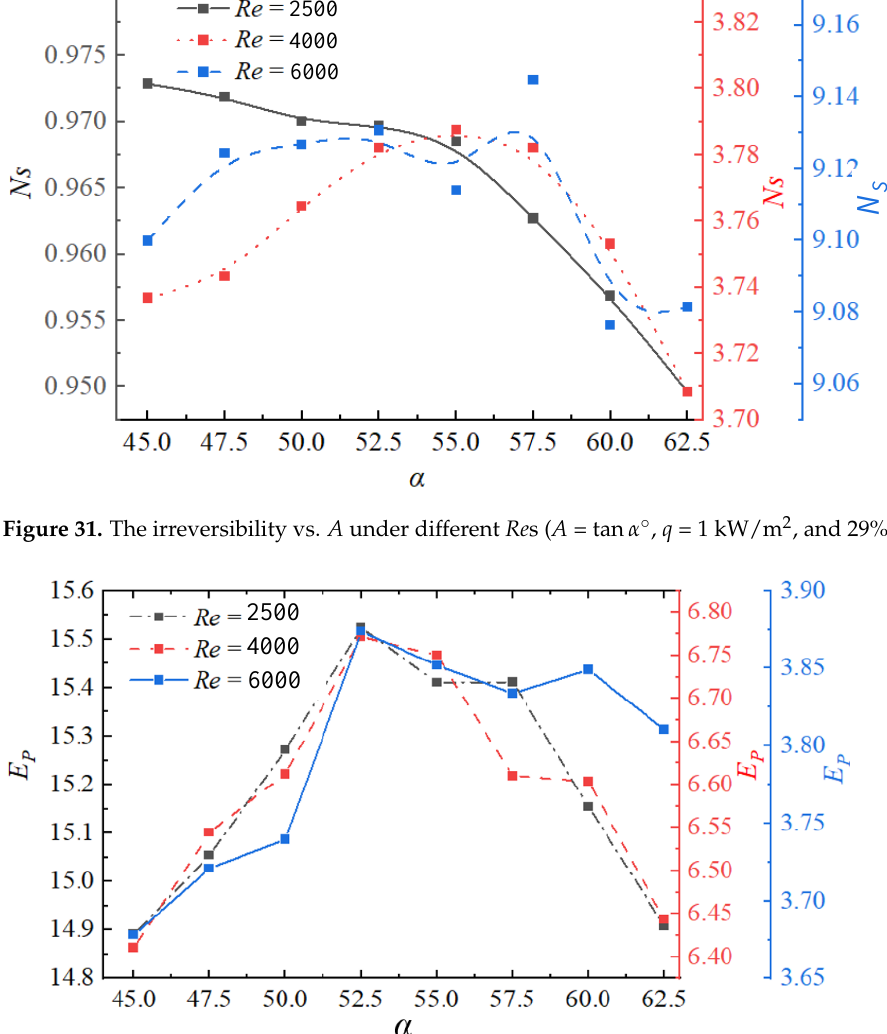
Figure 32. E P vs. A under different Re s ( A = tan 𝛼° , q = 1 kW/m 2 , and 29% Xe).